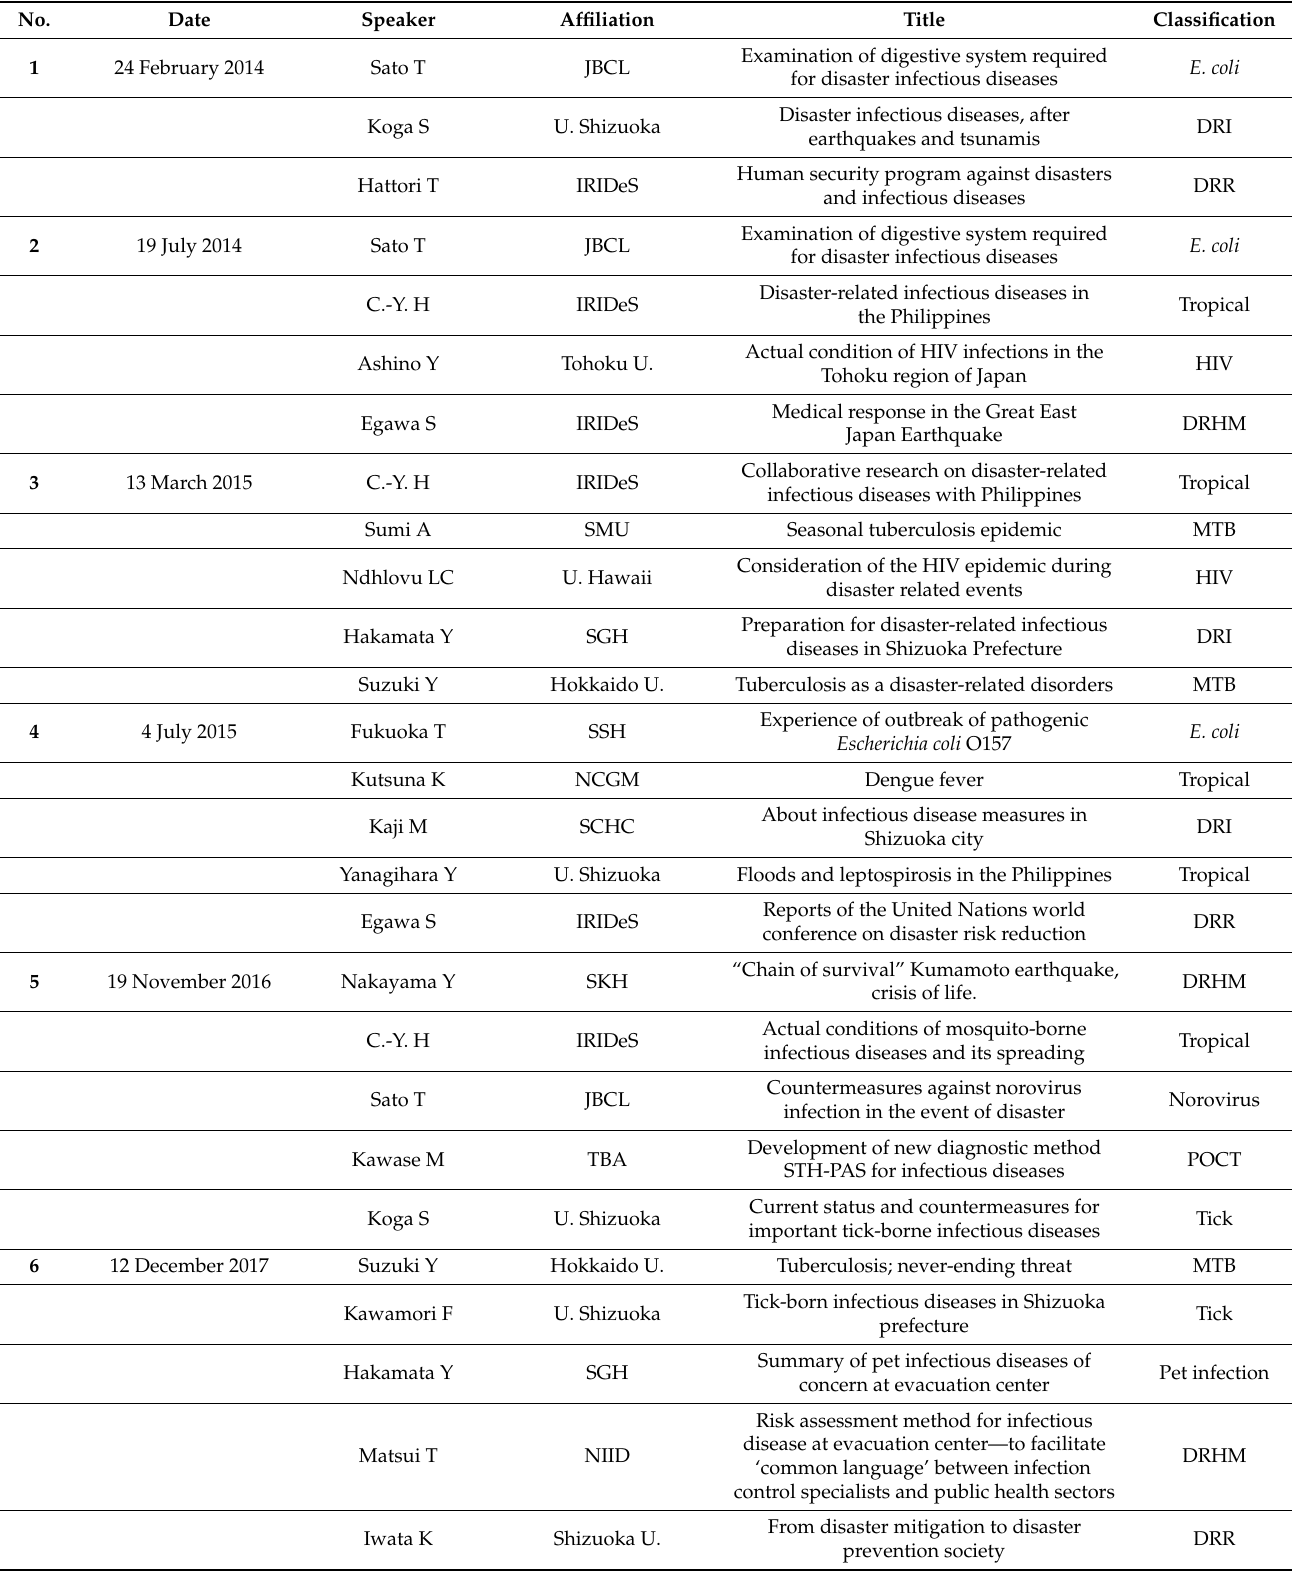
Table 1. Conference speakers and their titles in chronological